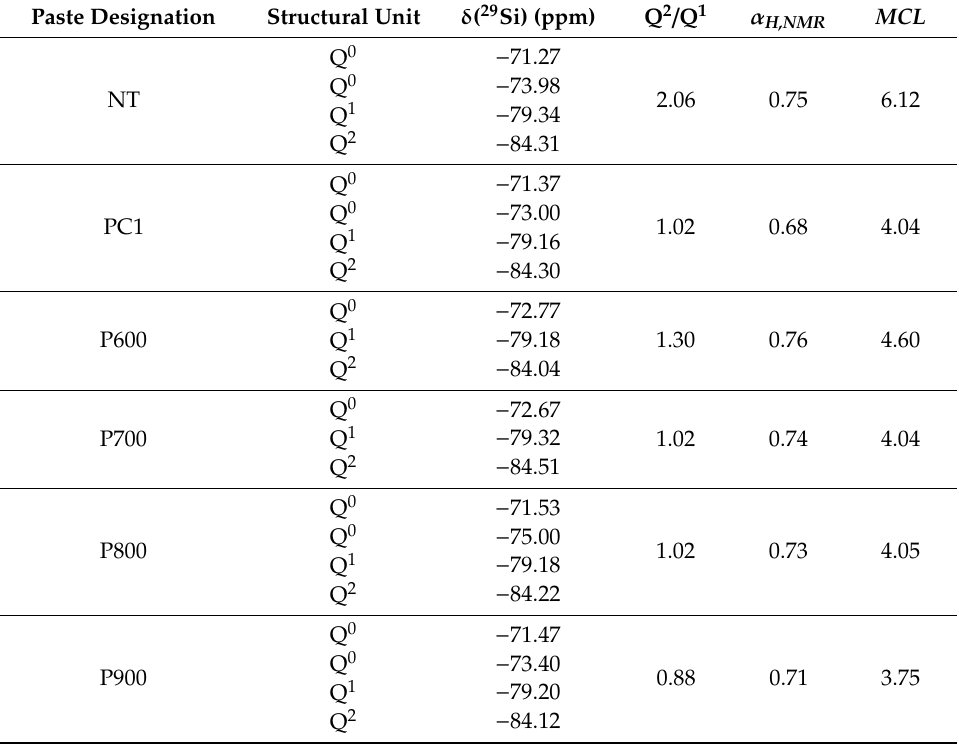
Table 9. Isotropic chemical shift δ ( 29 Si) and calculated value of α H,NMR and MCL of NT, PC1 and RC pastes.